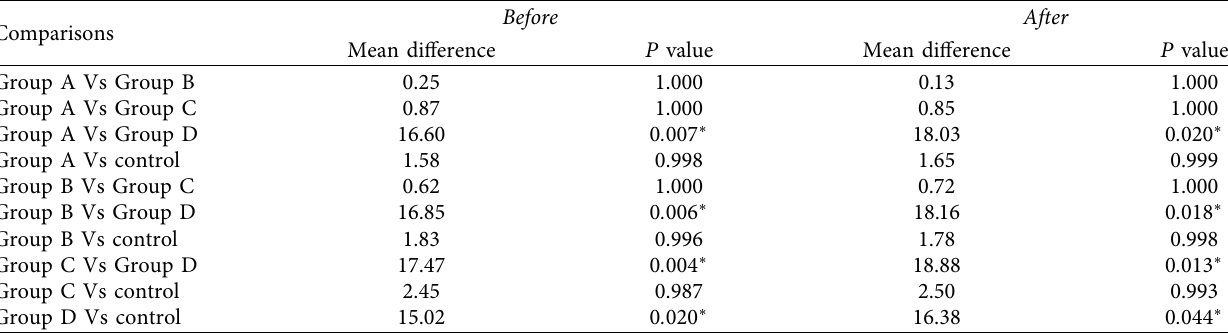
Table 8: Multiple comparison by Tukey Post Hoc